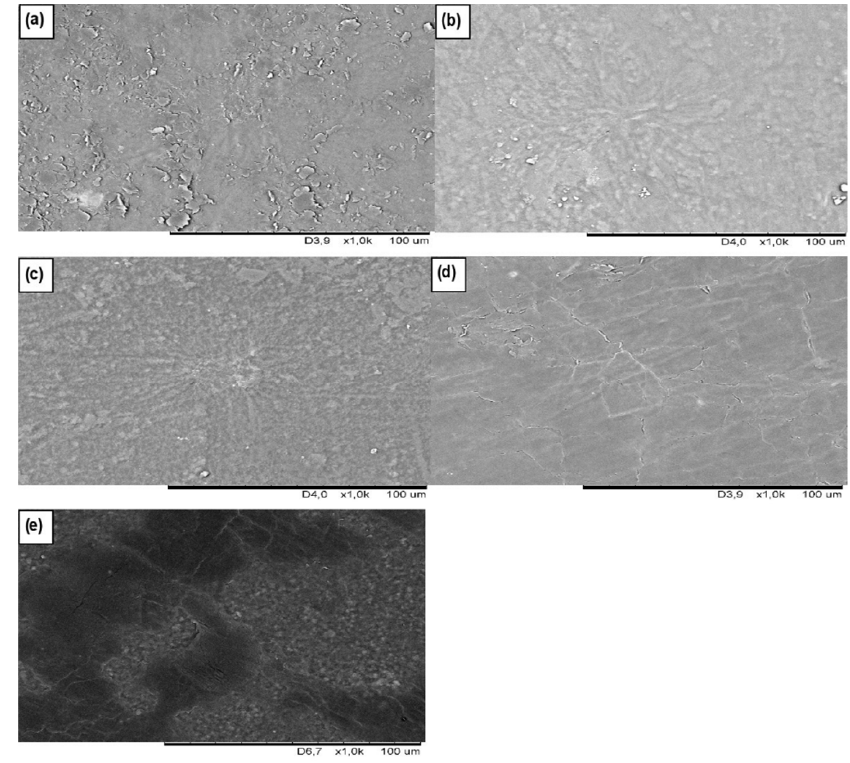
Figure 4. SEM images of the surface of: CR/BR/nano-Fe 2 O 3 ( a ); CR/BR/aerosil ( b ); CR/BR/ultrasil ( c ); CR/BR/chalcedony ( d ); CR/BR/sillitin ( e ).